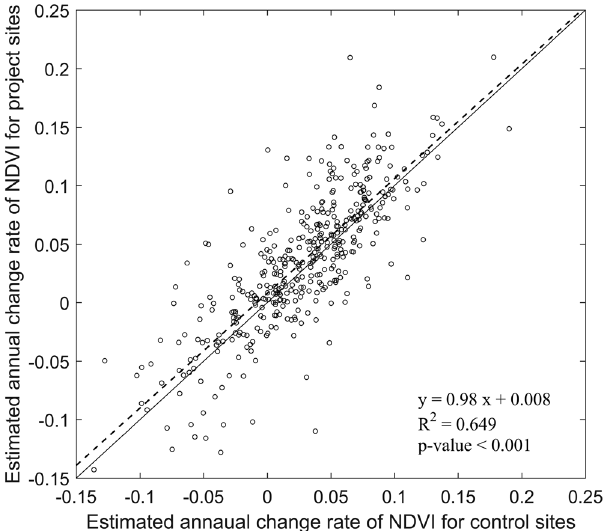
Figure 4. Comparison of NDVI change rates (i.e., Sen’s slope for 2006–2016) of project sites and their corresponding control sites. The 2006 farmland consolidation projects (n = 412) were used for pair comparison. Dash line denotes the regression